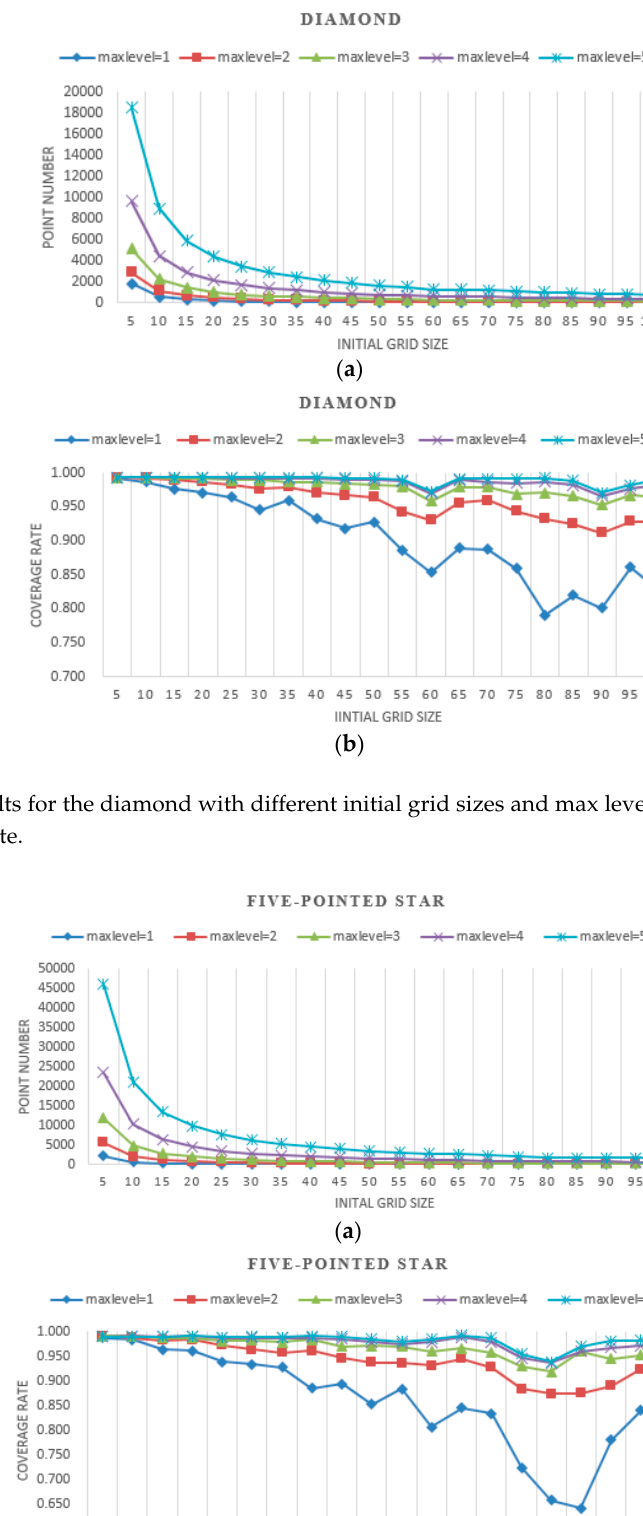
Figure 8. Results for the circle with different initial grid sizes and max levels. ( a ) point number; ( b ) coverage rate.